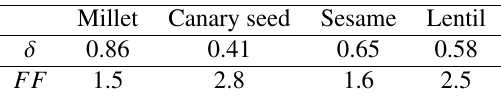
Table 2. Values of the parameters δ and the form factor FF for the seeds used in experiments